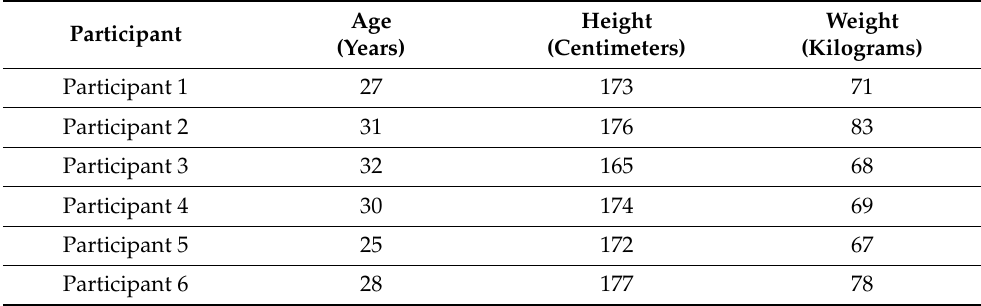
Table 2. Details of participants involved in this research